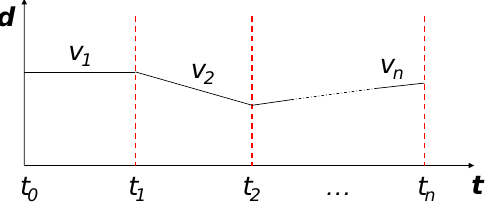
Fig. 1. Sub-sampling of PSI time series in n different time intervals, i.e. (t 0 − t 1 ) , (t 1 − t 2 ) , ( t n − 1 − t n ). The average deformation rates for each subsample, i.e. v 1 , v 2 , v n , are recalculated as simple linear regressions on ground deformation data ( d ).